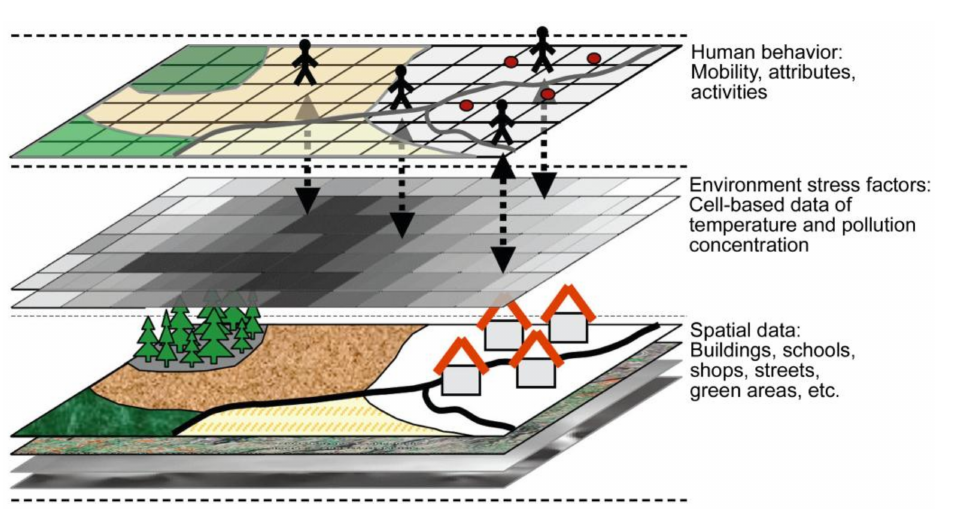
Figure 1. Illustration of the agent-based model framework for environmental exposure simulation (adapted and reedited from Leyk et al.